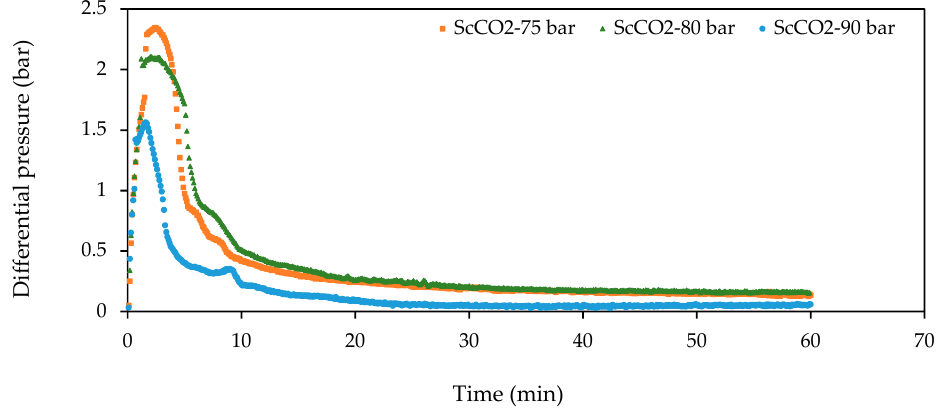
Figure 6. Effect of fluid pressure on the differential pressure profile of ScCO 2 –oil displacements conducted at 0.4 mL/min and 33 °C.